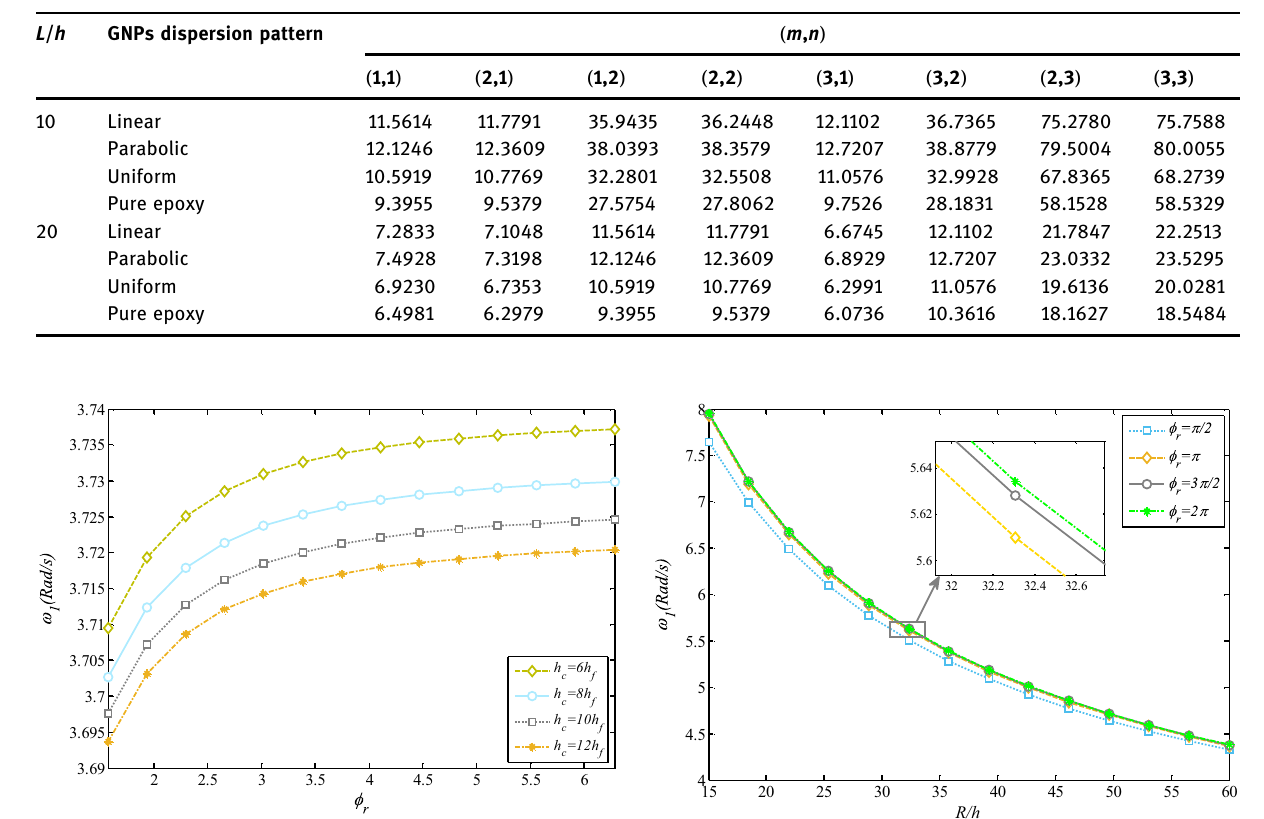
Figure 9: Rotation angle variations ’ e ff ect on the fundamental nat - ural frequency ( R = 100 h , L = 20 h , φ r = 2 π , and μ P = 2 ) .